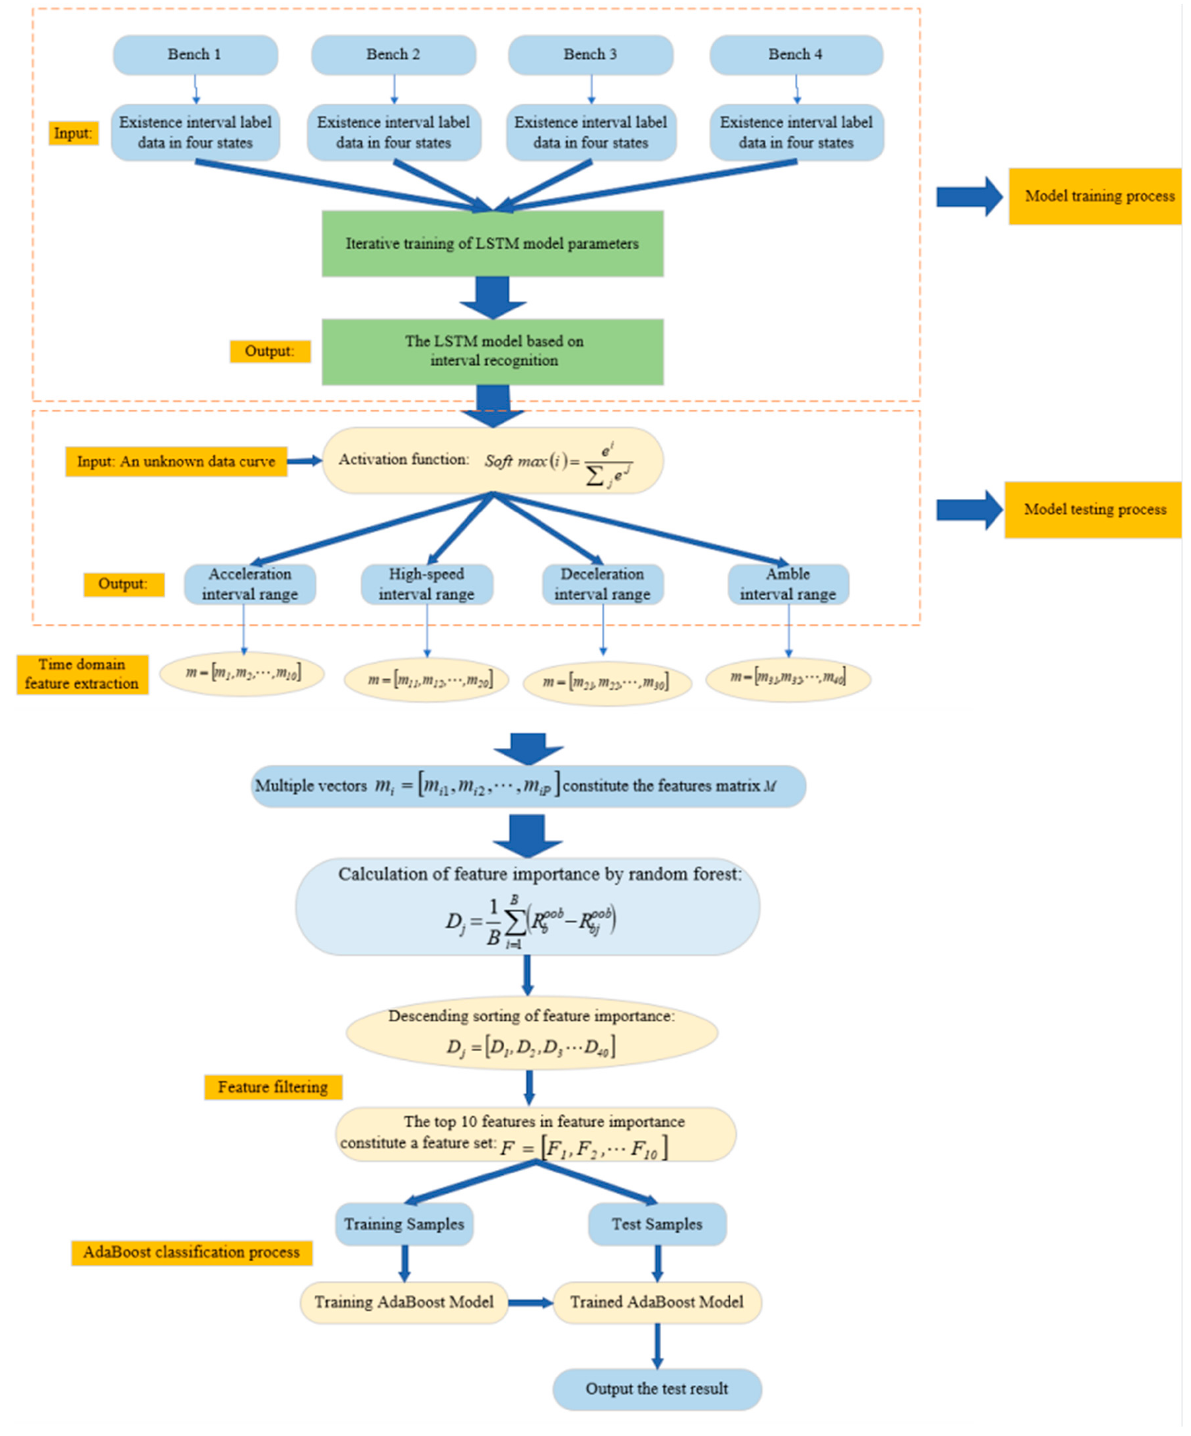
Figure 5. The framework of the proposed